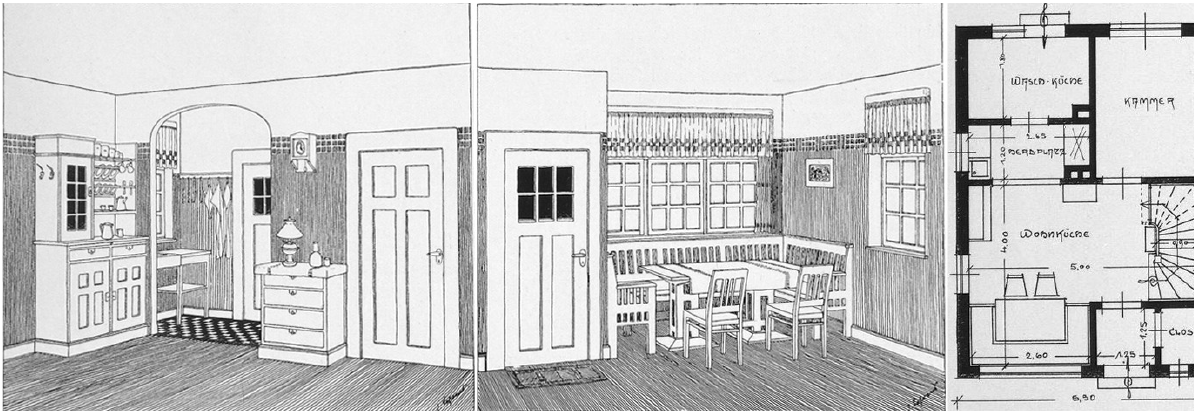
Figure 11. Wagner, Lotz, and Schacht’s designs for the workers’ colony of Einswarden, Bremen. Left and center illustrates the kitchen‐cum‐living room and right illustrates the floor plan. Source: Seeßelberg and Lindner (1909, p.